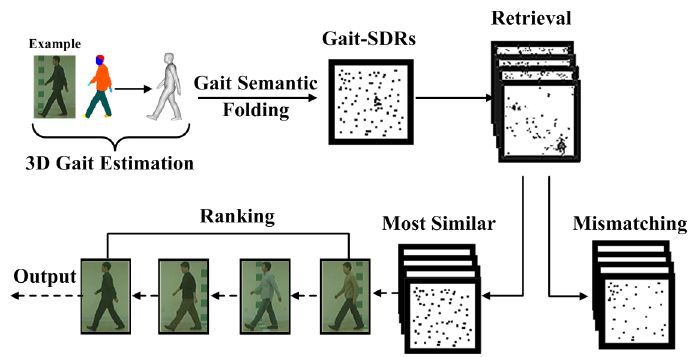
Figure 6. Illustration of retrieval using Gait SDRs.